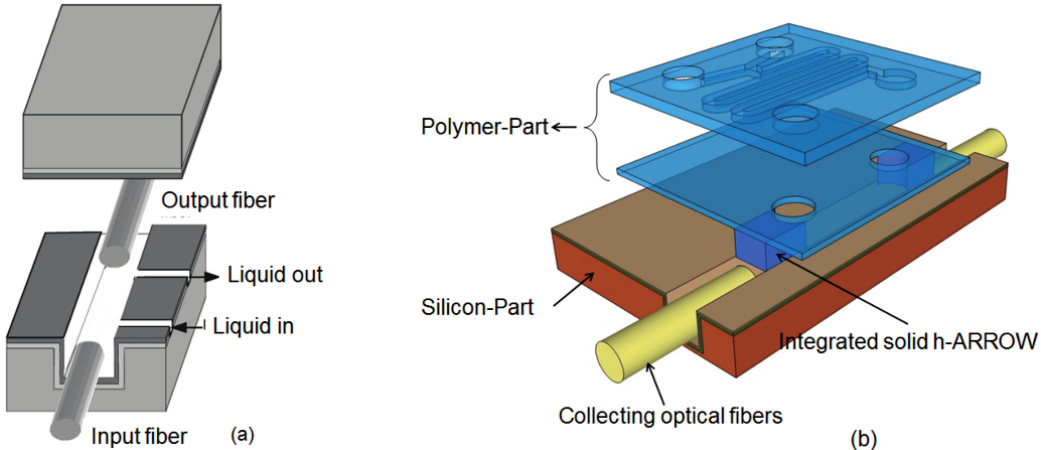
Figure 2. ( a ) Schematic of the microfluidic sensor for bulk refractometer RI measurements. Reprinted with permission from [42] (Copyright (2004) OSA) ( b ) Schematic drawing of the hybrid optofluidic platform. Reprinted with permission from [45] (Copyright (2014)